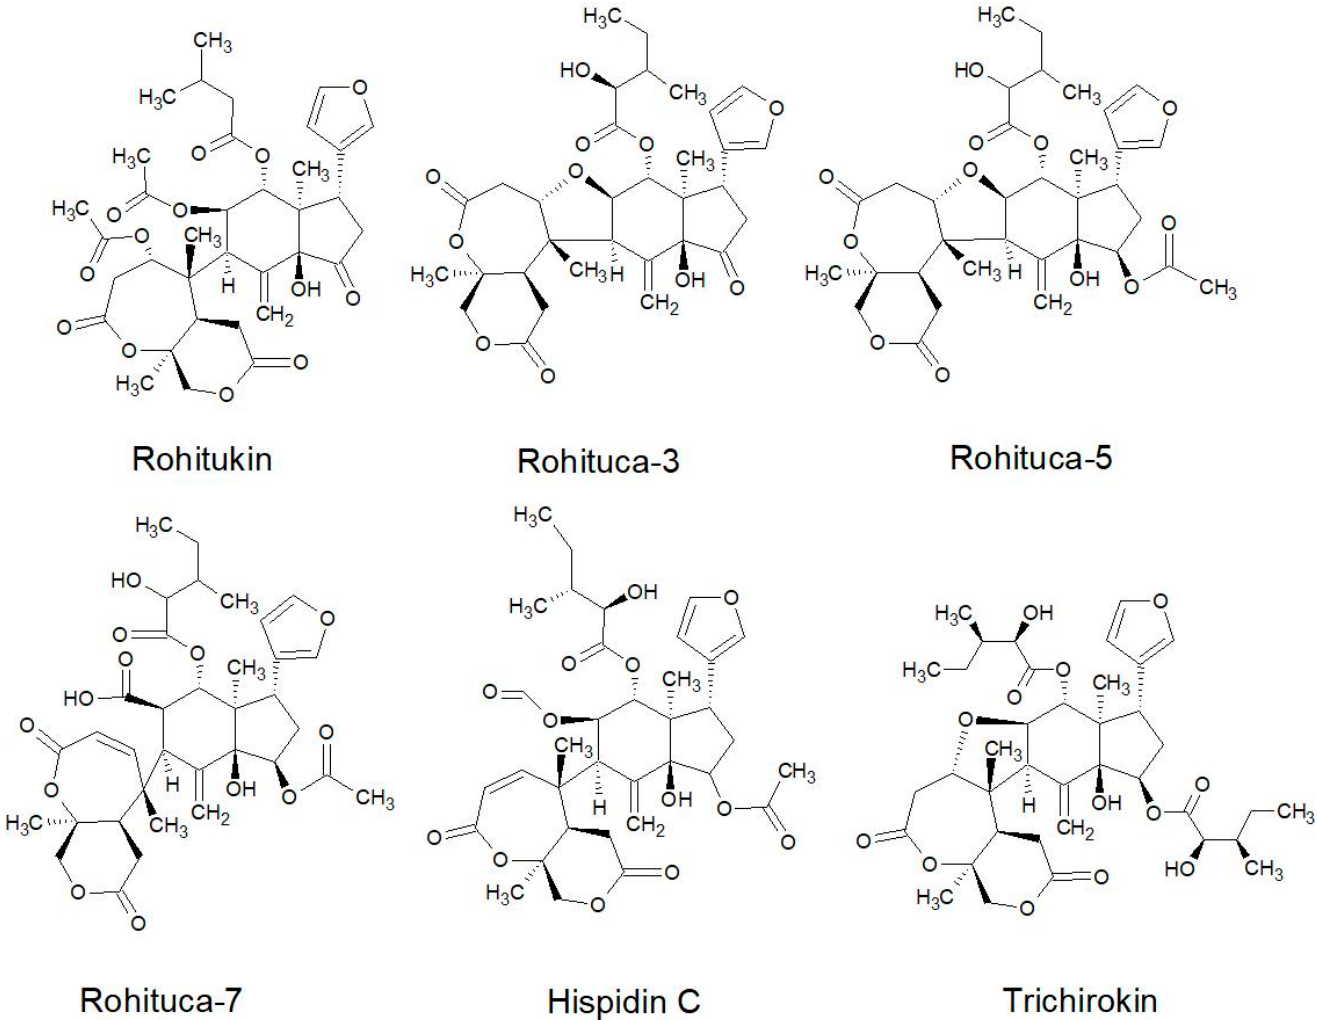
Figure 13. Rohituka series of limonoids reported from South African Meliaceae [24,117,118].